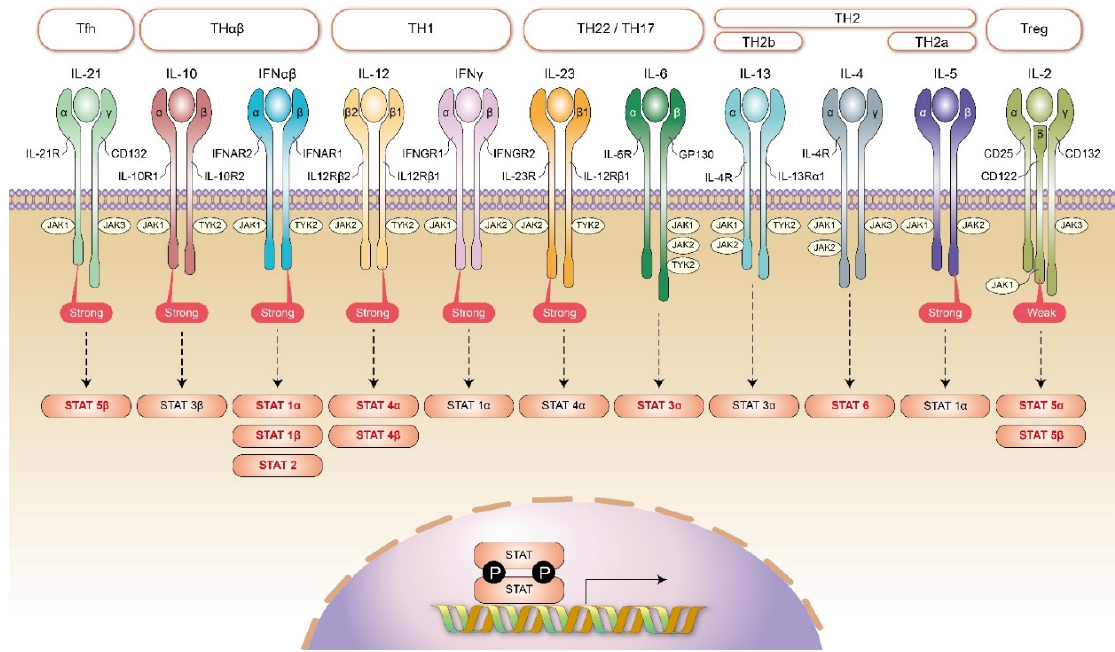
Figure 2. JAK/STAT signaling and the framework of host immunities. In Tfh immune reaction, the key mediating JAK molecules are JAK1 (stronger) and JAK3. They activate downstream STAT5 β . In Treg immune reaction, the key mediating JAK molecules are JAK1 and JAK3 (stronger). They activate downstream STAT5 α and STAT5 β . In TH1 immunity, the key cytokine receptors are interleukin-12 and IFN γ . The key mediating JAK molecules for interleukin-12 receptor are JAK2 and TYK2 (stronger). They activate downstream STAT4 α and STAT4 β . The key mediating JAK molecules for IFN γ receptor are JAK1 (stronger) and JAK2. They activate downstream STAT1 α . In TH2 immunity (including TH2a and TH2b immunities), the key cytokine receptor is interleukin-4 receptor. The key mediating JAK molecules for interleukin-4 receptor are JAK1, JAK2, and JAK3. They activate downstream STAT6. In addition, in TH2a immunity, an additional interleukin-5 receptor is needed. The key mediating JAK molecules for interleukin-5 receptor are JAK1 and JAK2 (stronger). They activate downstream STAT1 α . Additionally, in TH2b immunity, an additional interleukin-13 receptor is needed. The key mediating JAK molecules for interleukin-13 receptors are JAK1, JAK2, and TYK2. They activate downstream STAT3 α . In TH22/TH17 immunity, the key cytokine receptors are interleukin-6 and interleukin-23. The key mediating JAK molecules for interleukin-6 receptor are JAK1, JAK2, and TYK2. They activate downstream STAT3 α . The key mediating JAK molecules for interleukin-23 receptor are JAK2 (stronger) and TYK2. They activate downstream STAT4 α . In TH αβ immunity, the key cytokine receptors are IFN α / β and interleukin-10. The key JAK molecules for IFN α / β are JAK1 and TYK2 (stronger). They activate downstream STAT1 α , STAT1 β , and STAT2. The key JAK molecules for interleukin-10 receptor are JAK1 (stronger) and TYK2. They activate downstream STAT3 β .